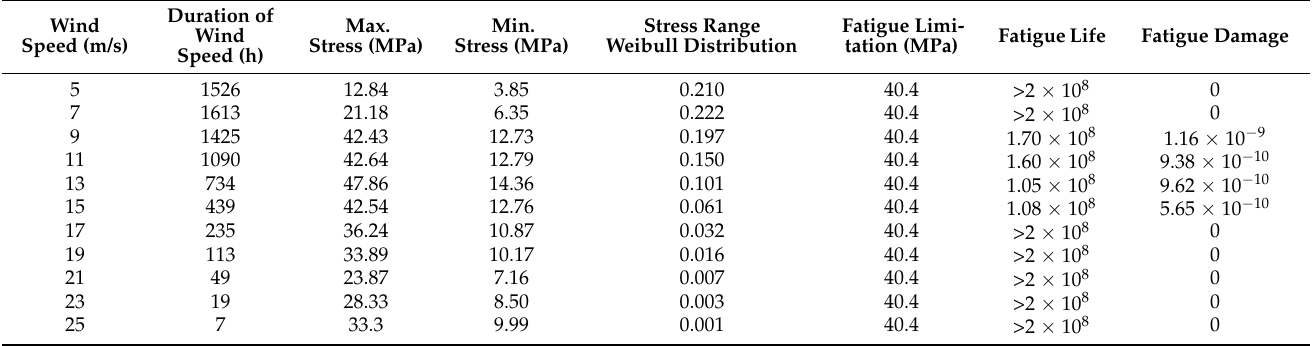
Table 10. Wind speed distribution and fatigue damage in a year.